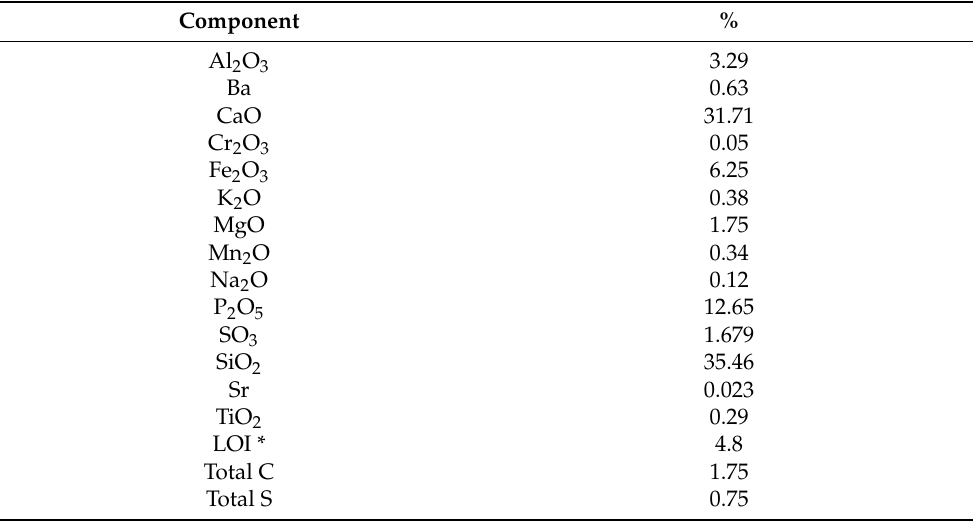
Table 1. Whole rock analysis of skarn phosphate (SP) samples.